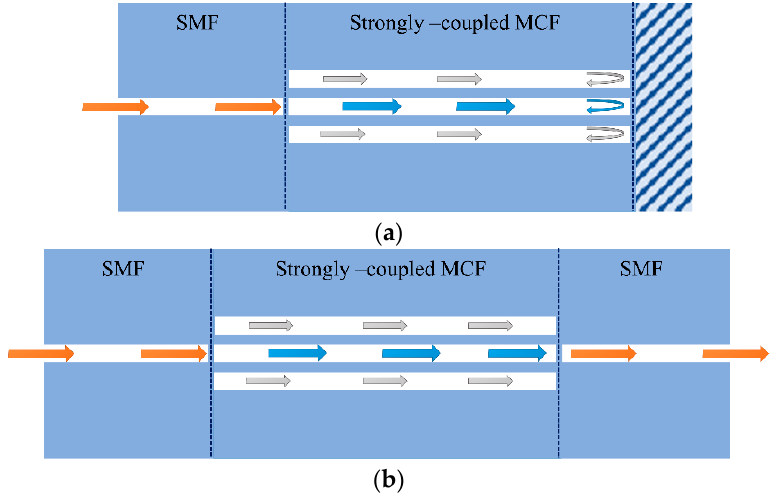
Figure 20. Schematics of a supermode interferometer with ( a ) a reflected structure; ( b ) a transmitted structure.